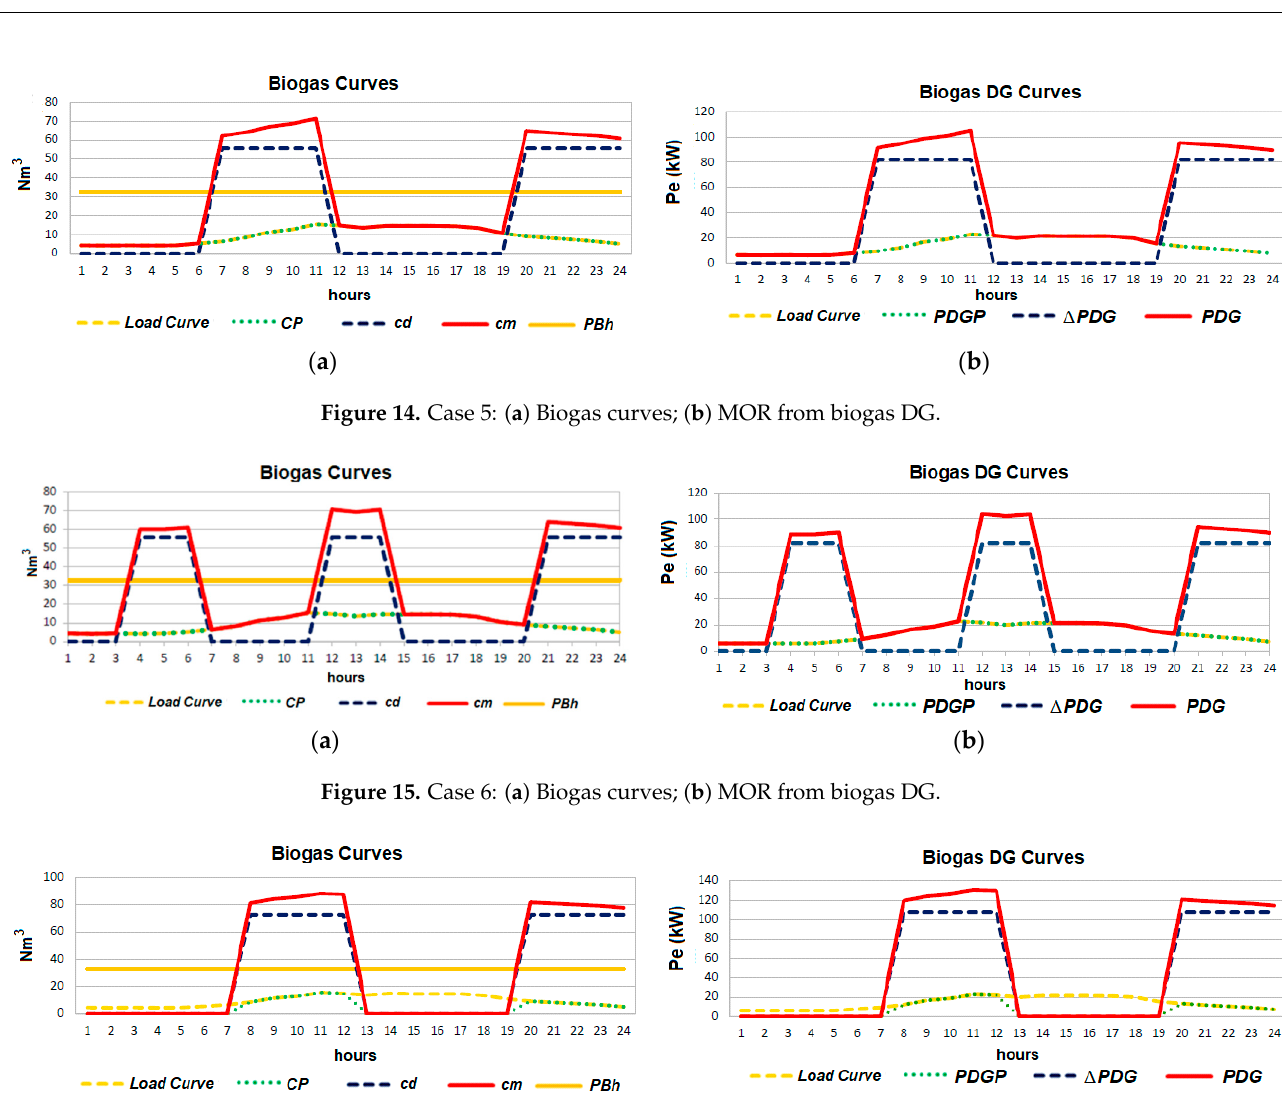
Figure 13. Case 4: ( a ) Biogas curves; ( b ) MOR from biogas DG.